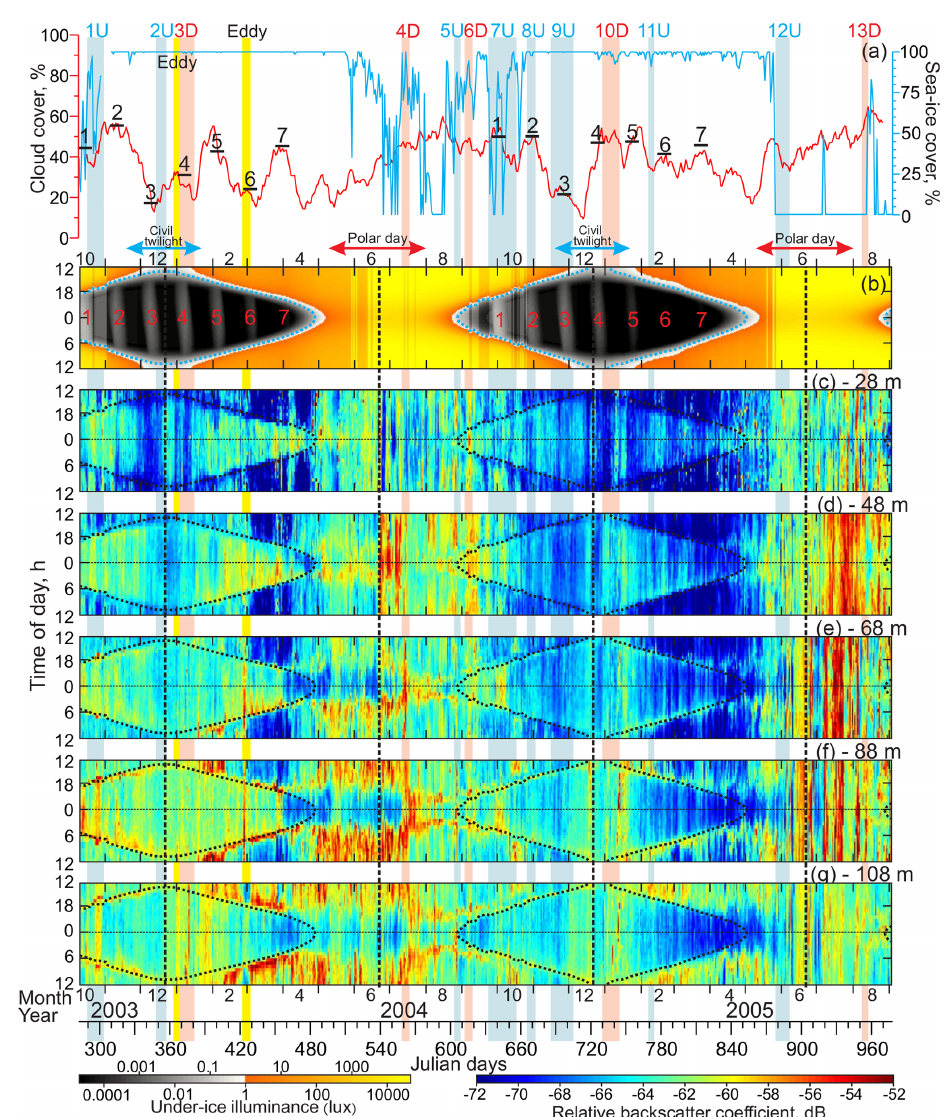
Figure 7. (a) Time series of sea-ice concentrations (blue, %) and 15d running mean of total cloud cover (red, %). Actograms of (b) modeled under-ice illuminance (lux) based on HYCOM + CICE sea-ice thickness and (c–g) MVBS (dB) at five depth levels: (c) 28, (d) 48, (e) 68, (f) 88, and (g) 108m. The dotted blue (b) and black (c–g) lines depicts the 0.1 lux threshold. Red and blue arrows at the top indicate the polar day and civil twilight, respectively. Red numbers reference the full moon occurrences, and black horizontal segments in (a) indicate the mean cloud cover for these periods. Black dashed vertical lines depict solstices. Red and blue shading highlight the downwelling (D) and upwelling (U) events, respectively, with their reference numbers on the top. Yellow shading highlights